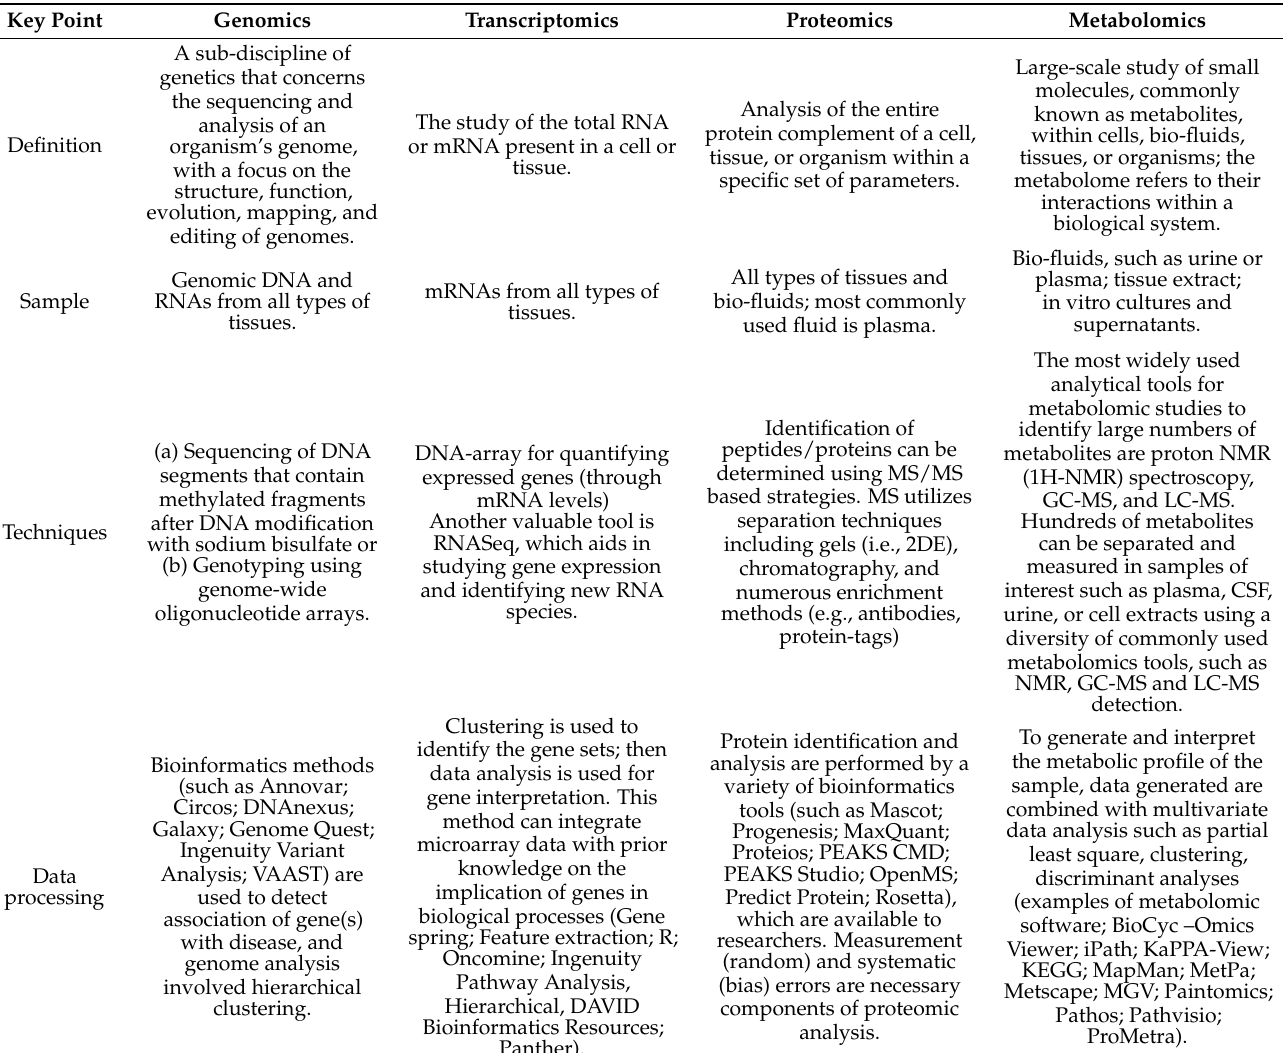
Table 1. Omics applications used in pharmaceutical research and